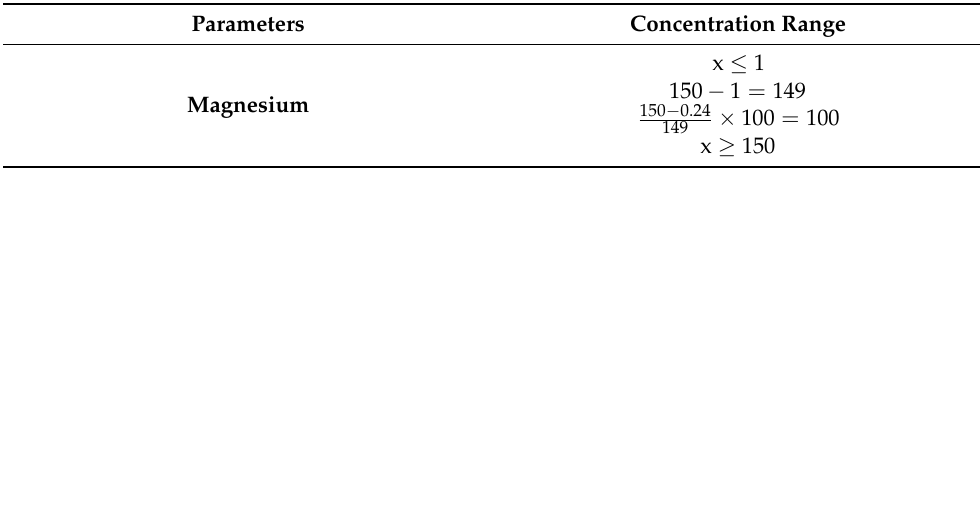
Table 16. Subindex calculation by concentration